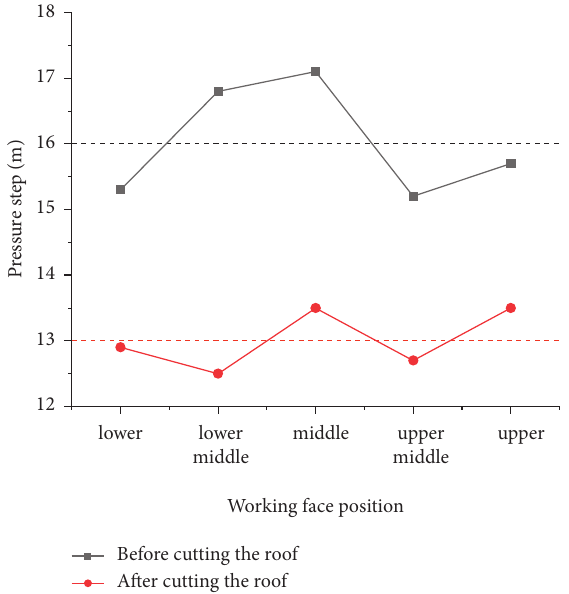
Figure 5: Different parts of the working face to press the step distance curve.